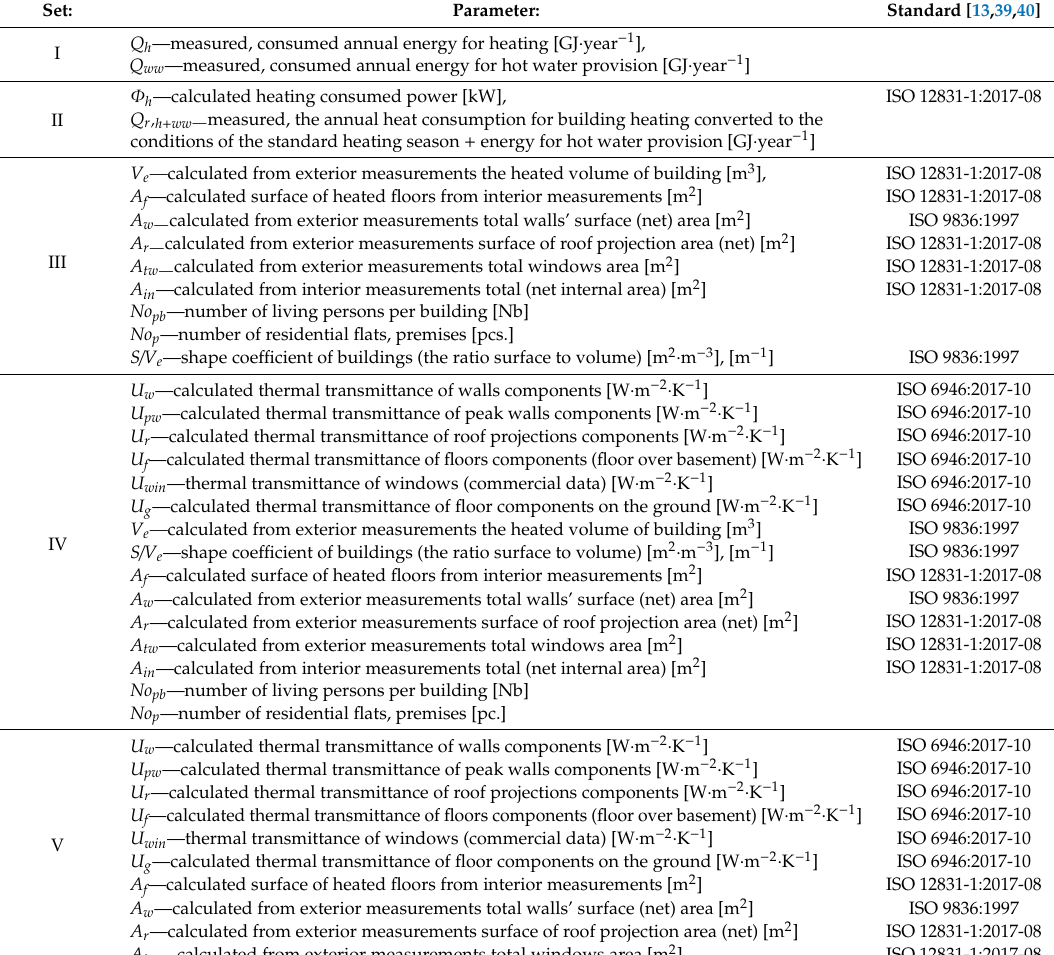
Table 2. Selected sets of input variables for modelling heating energy needs for improved buildings in a four-season